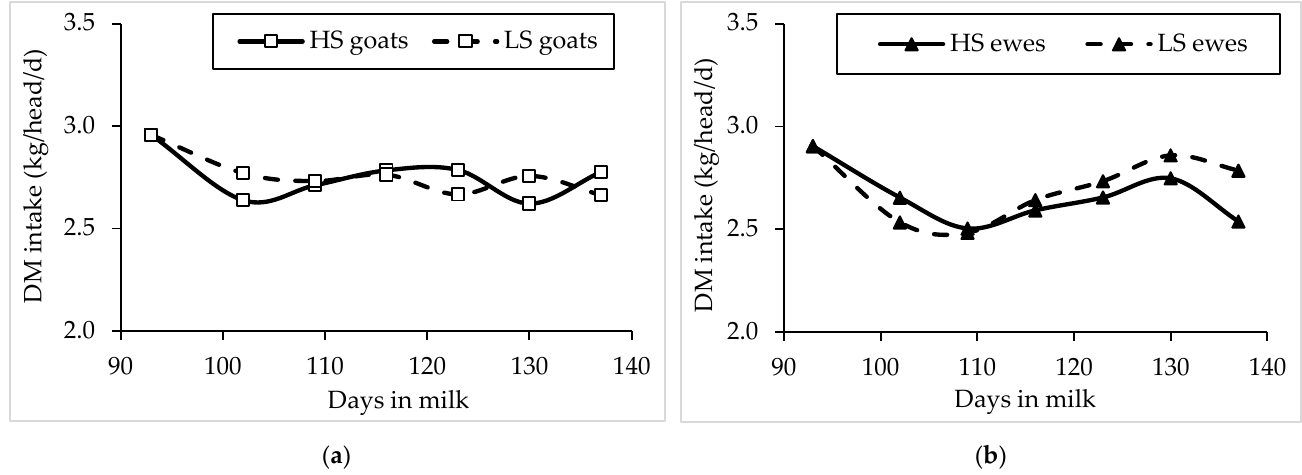
Figure 1. Evolution of dry matter (DM) intake (kg/d) in mid-lactating Saanen goats ( a ) and Sarda ewes ( b ) fed high-starch (HS) and low-starch (LS) diets. The symbols indicate the mean of the daily measurements of the group fed DM intake.